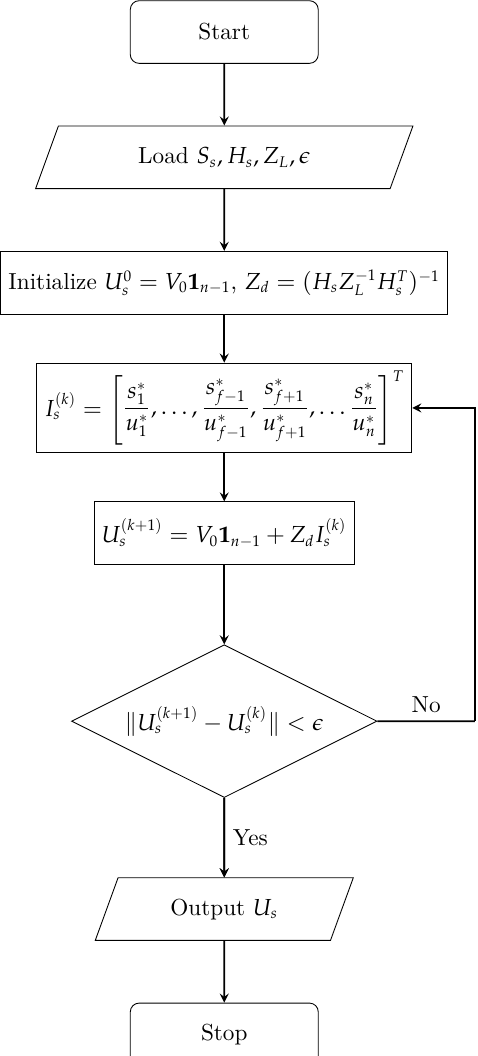
Figure 2. The flowchart of graph-based